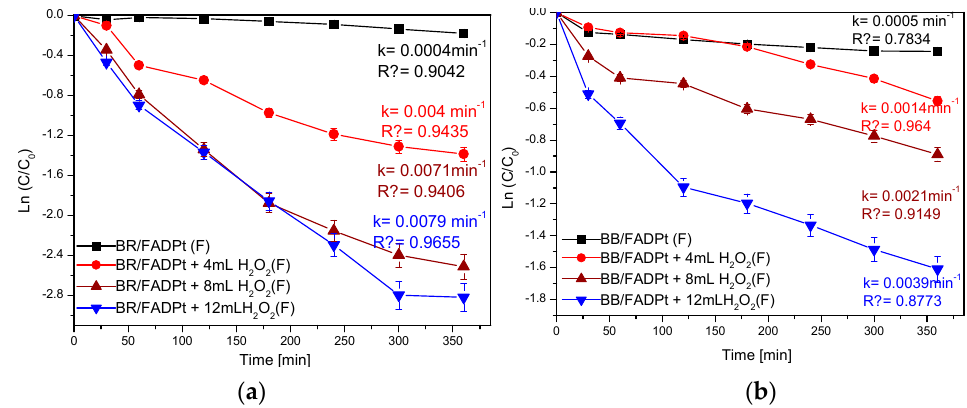
Figure 12. Photocatalysis of dyes ( a ) BR; ( b ) BB (R 2 is the squared value of the linear regression). The BR photodegradation also proved to be faster (k = 0.0079 min − 1 ) as compared to BB (k = 0.0039 min − 1 ), thus allowing a more significant quantity of oxidizing species to be involved. In the working conditions, pH = 7.89, the oxygen production from H 2 O 2 is em- ployed, which afterwards can contribute to decreasing recombination. H 2 O 2 was used as an electron scavenger to accelerate decolorization and degradation of the BR and BB dyes.